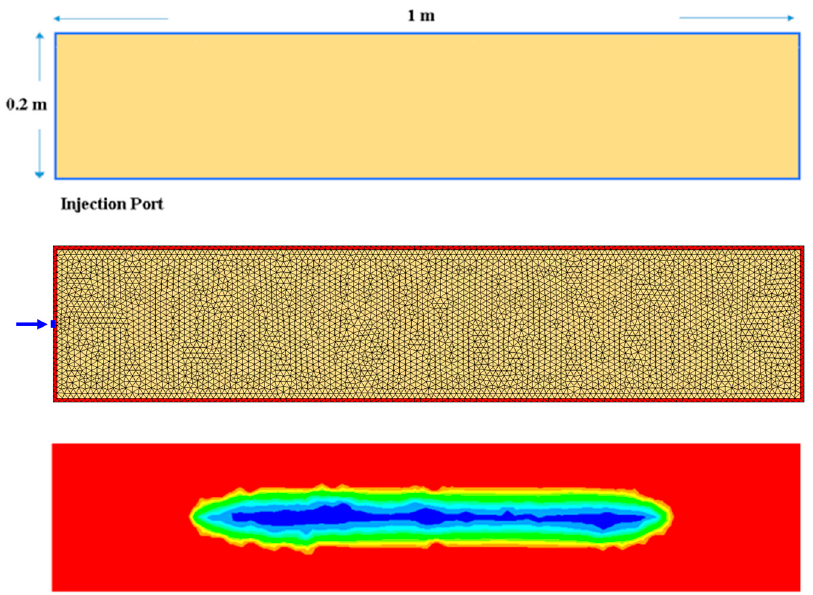
Figure 6. Peripheral injection case: geometry ( top picture ), mesh with surrounding high permeable segments ( middle picture ) and filling pattern with air entrapment ( bottom picture ).